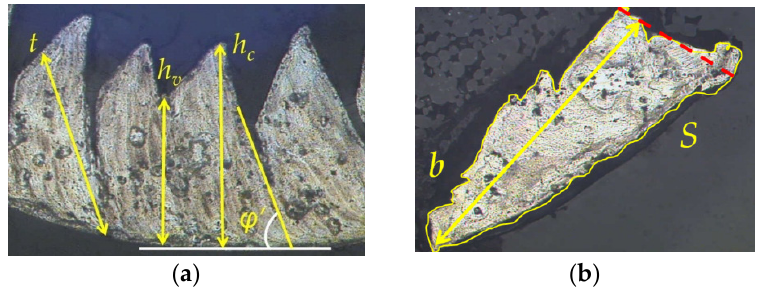
Figure 4. ( a ) Longitudinal and ( b ) transverse chip geometric parameters.